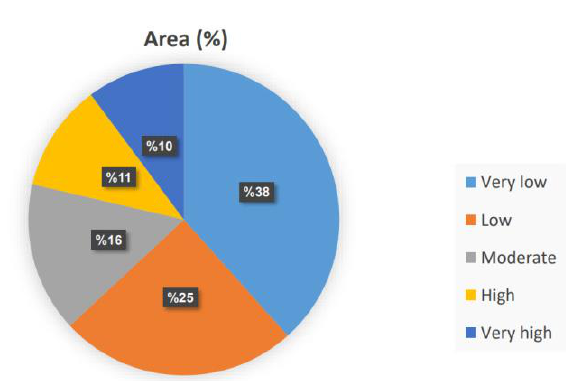
Figure 5 . Percentages of the area in different susceptibility